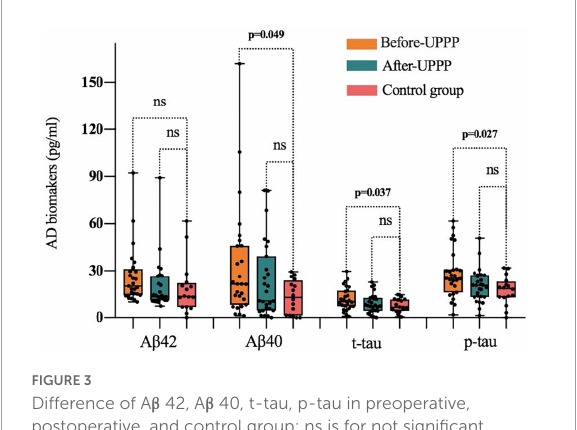
FIGURE3 Difference of A β 42, A β 40, t-tau, p-tau in preoperative, postoperative, and control group; ns is for not significant ( p > 0.05). The symbol • represents the value of the patient’s biomarker.